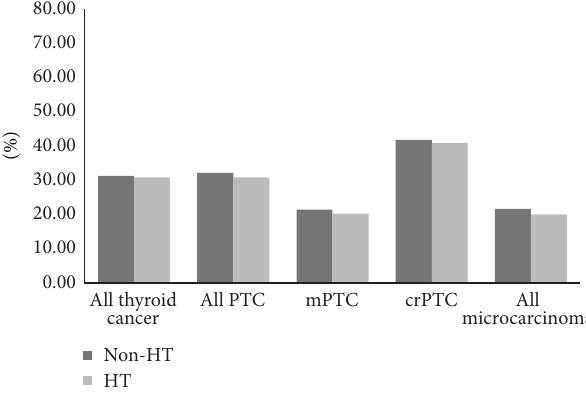
Figure 2: Local lymph node metastasis in different groups. No significance was found between HT and non-HT